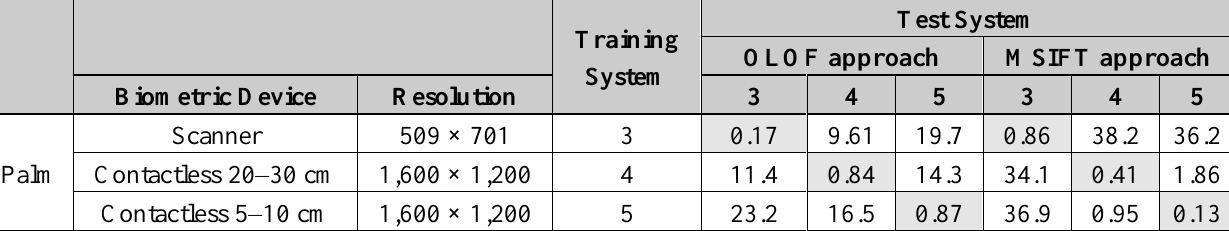
Table 9. Interoperability matrix for palm print approaches (OLOF and MSIFT) in terms of EER